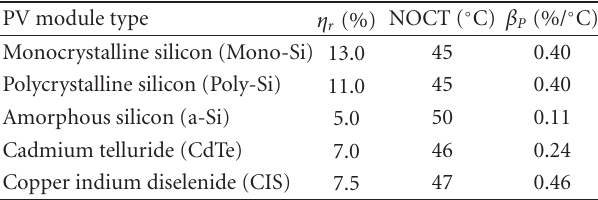
Table 3: Values of PV module-related